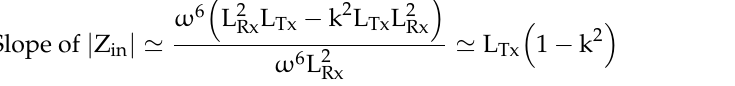
Figure 6. Z in − 1 and Z in − 2 are the input impedances of the two systems,